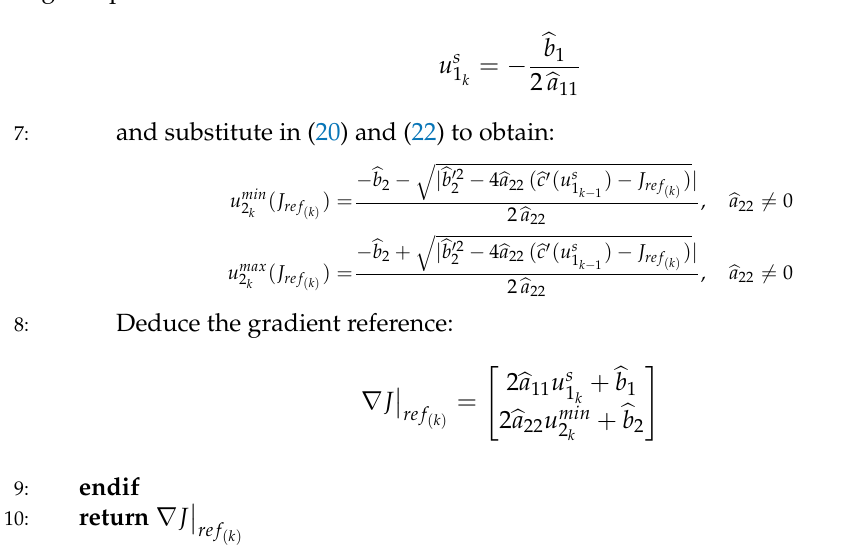
Algorithm 2 considers a suboptimal setpoint tracking with minimization of both inputs. Starting from arbitrary initial conditions u 1 estimate the minimal values u min and the static map parameter estimates at time k